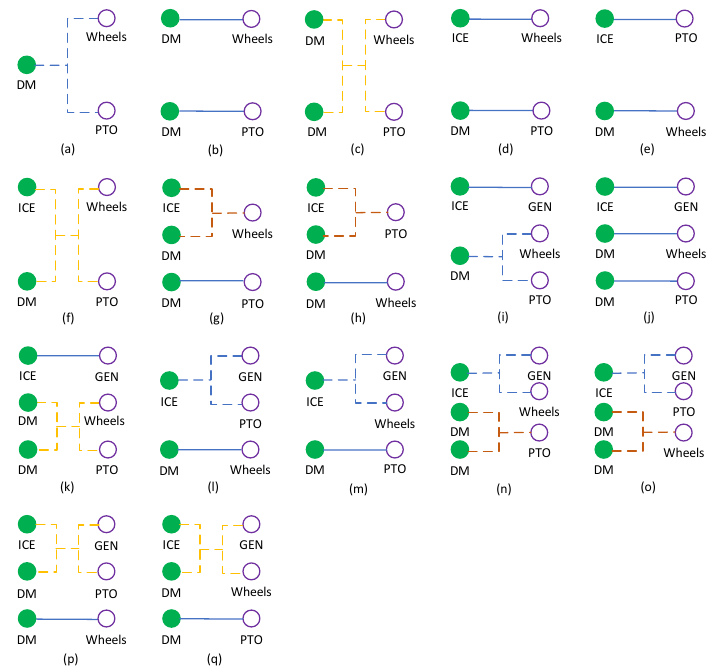
Figure 1. Schematic diagram of powertrain topologies for electric tractors. Note: The solid blue lines represent a direct mechanical connection via a pair of gears or reducer, the blue dashed lines represent a power split device, the yellow dashed lines represent a power split-coupling device, and the brown dashed lines represent a power coupling device.